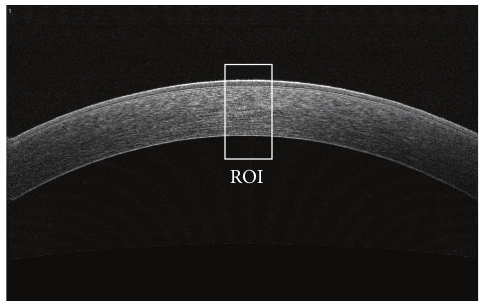
Figure 1: OCT grayscale corneal tomogram and the region of inter- est (ROI) on the corneal apex. (in this case: horizontal dimension: 6 mm, 1016 pixels; vertical dimension: 4mm, 640 pixels.)